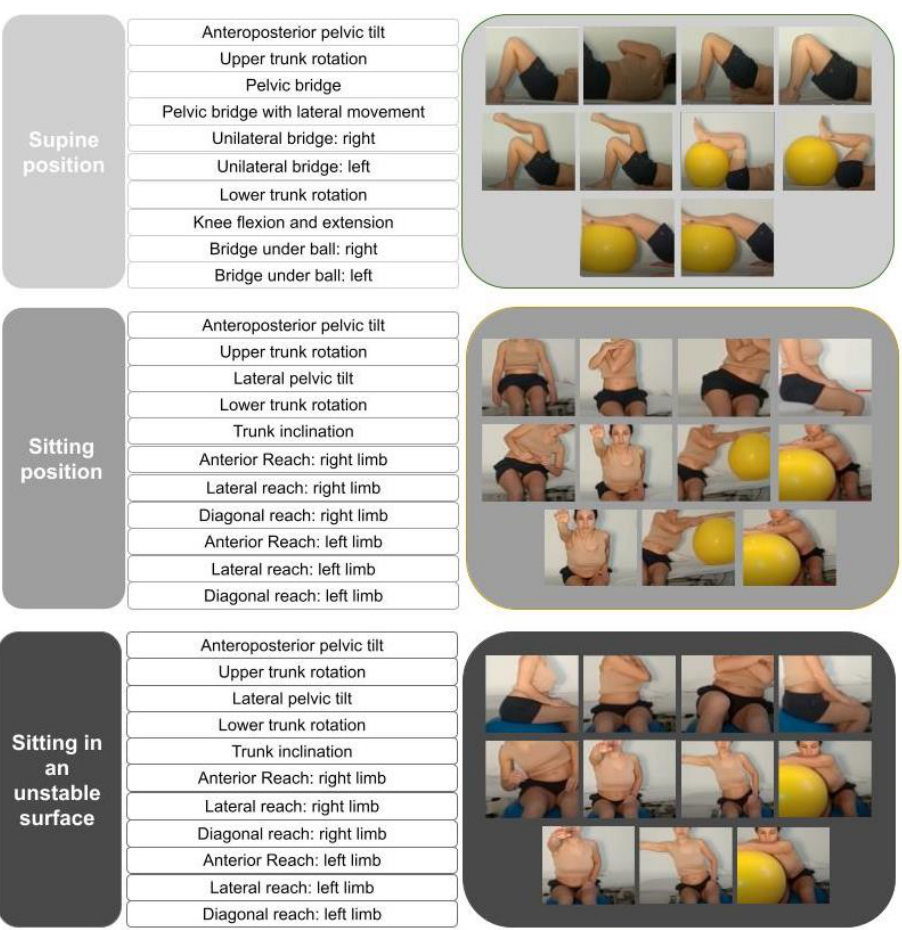
Figure 1. Core-stability exercise protocol for stroke patients included in the telerehabilitation App.